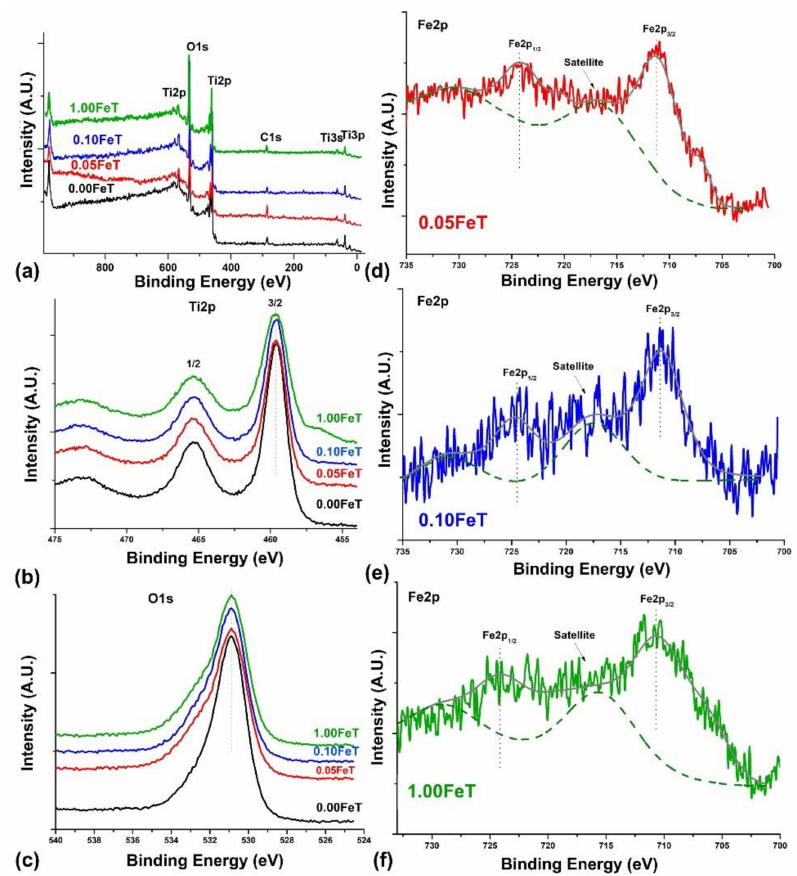
Figure 3. Wide-survey XPS spectra ( a ) and high resolution XPS spectra of Ti 2p ( b ), O 1s ( c ), and Fe 2p ( d – f ) of the undoped (0.00FeT) and Fe-doped nanoparticles (0.05FeT, 0.10FeT, and